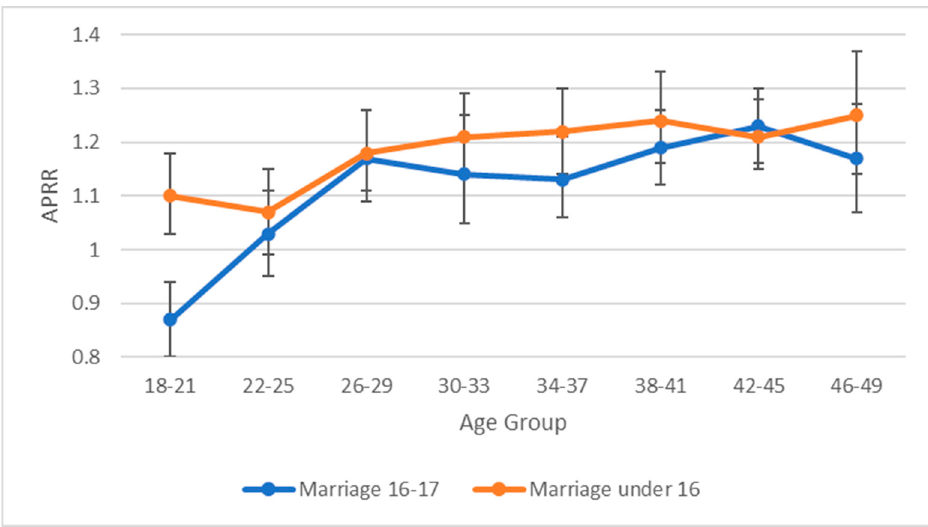
Figure 1. Prevalence rate ratios with 95% CIs (adjusted for within age group variation in age) for women with disabilities having been exposed to child marriage at age 16–17 and under 16 by age group.